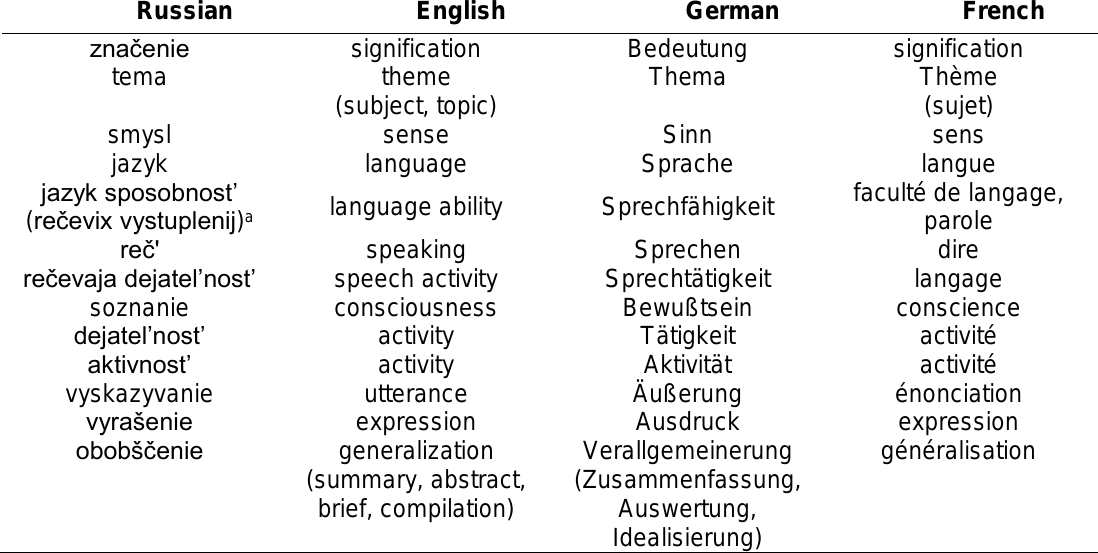
Table 1. Correspondence of Key Theoretical Terms in the Traditions of Cultural-Historical Activity Theory and